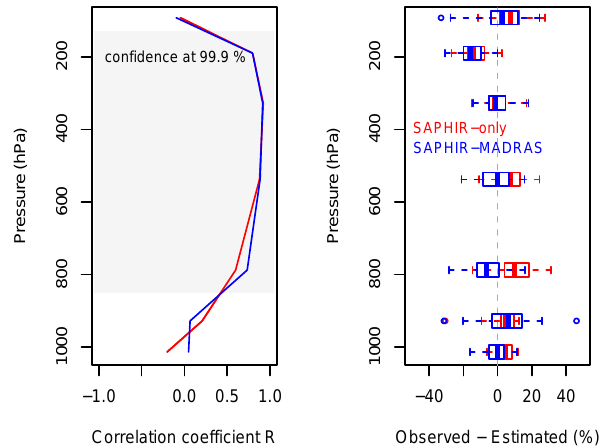
Figure 7. Vertical profiles of R (left) and differences (right, in %RH) for the SAPHIR-only (red) and the SAPHIR-MADRAS (blue) retrievals, computed over the subset of 50 radiosonde RH profiles from the CINDY/DYNAMO/AMIE campaign. For the pro- files of the differences between the observed and estimated RH, the box and whiskers diagram indicates for each layer the median (the central vertical line) and the lower and upper quartiles (left and right edges of the box). The whiskers indicate the lower and upper limits of the distribution within 1.5 times the interquartile range from the lower and upper quartiles, respectively.